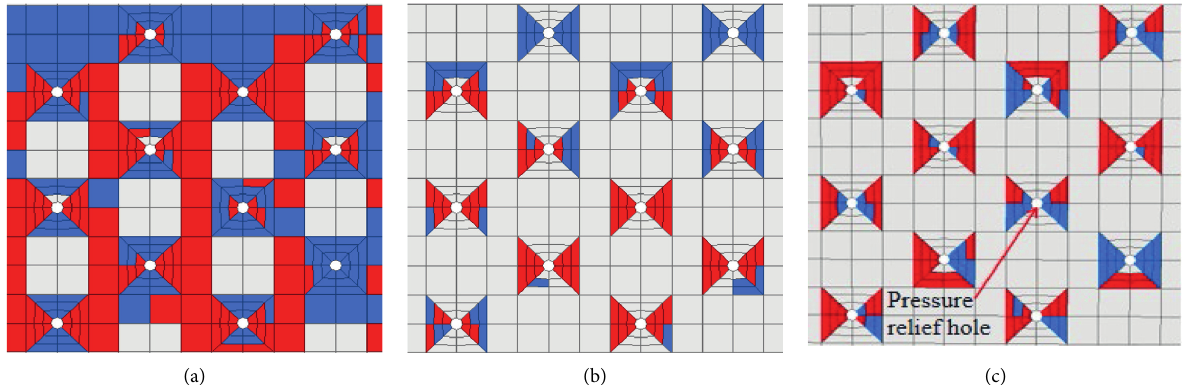
Figure 9: Distribution law of plastic zone of 100 mm pressure relief hole. (a) 4 m from the coal rib. (b) 6m from the coal rib. (c) 8m from the coal rib.